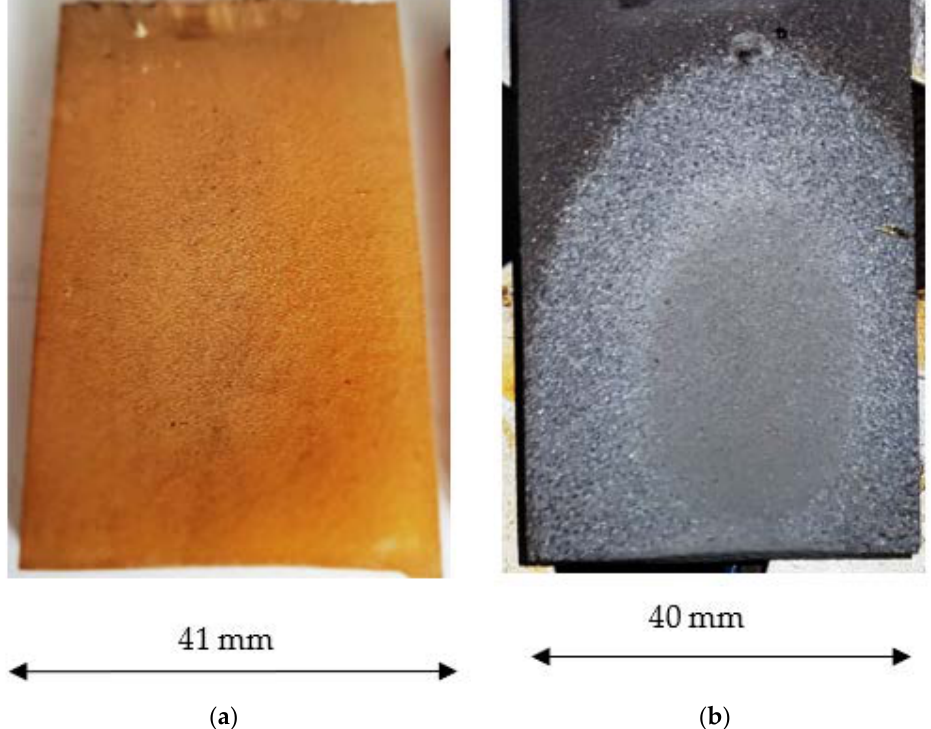
Figure 11. Surface erosion of unfilled ( a ) and filled ( b ) samples at an impingement angle of 45°.